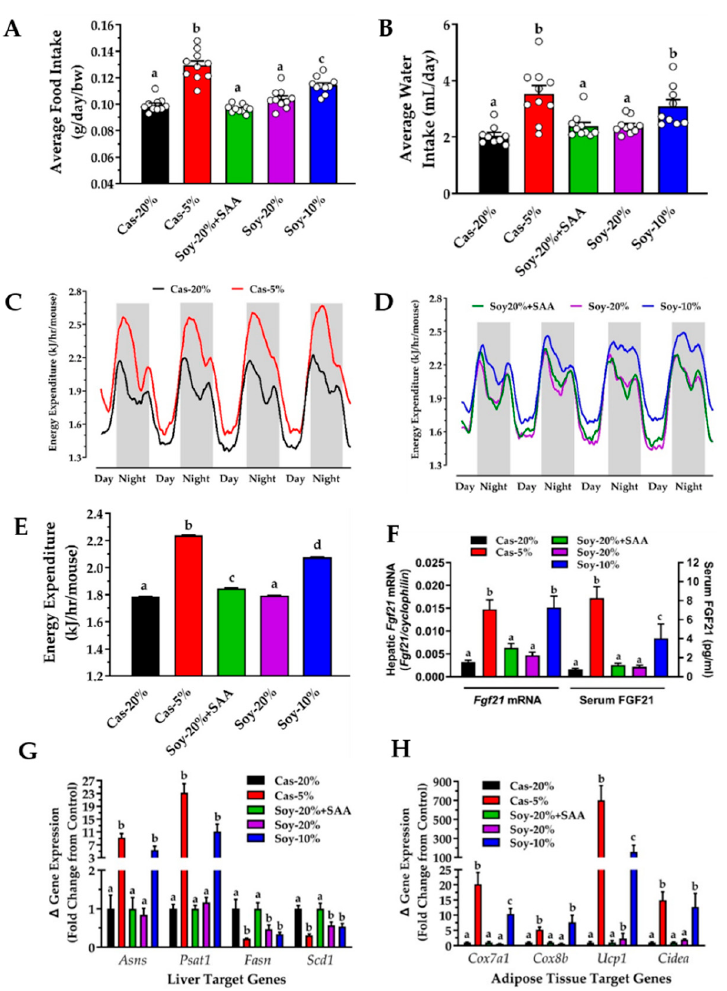
Figure 2. Assessment of impact of protein restriction on average food intake ( A ), average water intake ( B ), 96 h continuous energy expenditure in casein groups ( C ) and soy groups ( D ), average energy expenditure for all groups ( E ), Fgf21 mRNA and serum FGF21 ( F ), liver target genes ( G ), and inguinal white adipose tissue target genes ( H ). Food intake and water intake were measured at weekly intervals, and average food intake was expressed per unit body weight. The means of food intake and water intake were averaged over the entire study. Energy expenditure was measured continuously for 4 days after a 3-day equilibration period and calculated by ANCOVA as described in Materials and Methods. Serum and liver collected at end of study was used to measure FGF21 and target gene mRNA levels. Inguinal WAT collected at the same time was used to measure target gene mRNA levels. The respective end points were analyzed by one-way ANOVA and means annotated with different letters differ at p < 0.05. Data in each figure panel are presented as the mean ± SEM, n = 9–10.